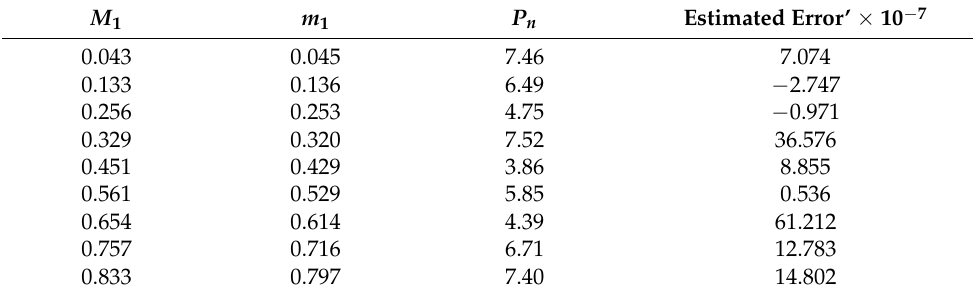
Table 4. The input data for low conversion and r 1 = 0.72 and r 2 = 0.92 (LC2).